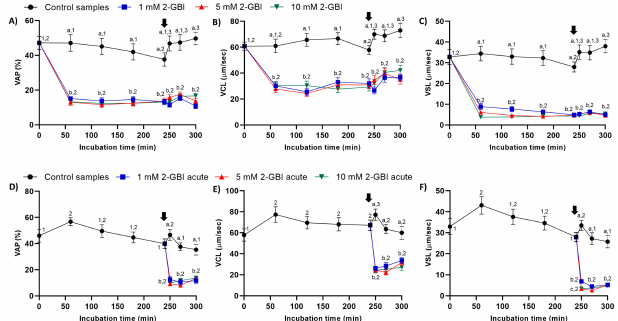
Figure 3. Kinematic parameters of curvilinear velocity (VCL), straight-line velocity (VSL) and average path velocity (VAP) throughout the incubation of sperm in capacitating medium (control samples) and capacitating medium plus 1 mM, 5 mM or 10 mM 2-GBI. 2-GBI blocker was added to capacitating medium either at 0 min in experiment 1 ( A – C ) or after 240 min of incubation in experiment 2 ( D – F ; acute). Di ff erent superscript letters (a–c) indicate significant di ff erences ( p < 0.05) between treatments within the same time point, and di ff erent superscript numbers (1–3) indicate significant di ff erences ( p < 0.05) between time points within a given treatment. Results are expressed as mean ± SEM ( n = 10). The arrow indicates the time at which 10 µ g / mL of progesterone was added to all samples (i.e., 240 min of